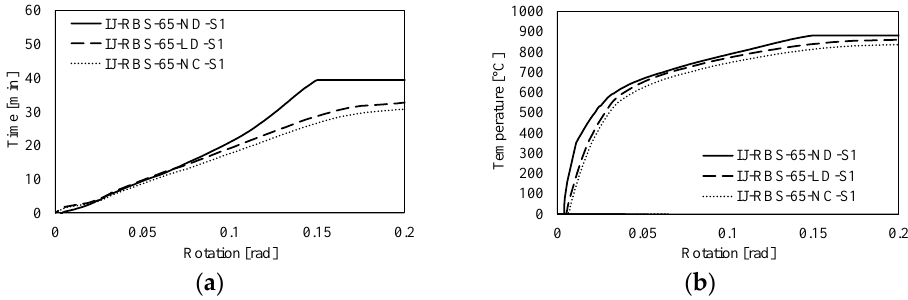
Figure 14. Influence of the cyclic pre-damage on the IJ-RBS-65 joints subjected to the S1 scenario in terms of time-rotation ( a ) and temperature-rotation curves ( b ).